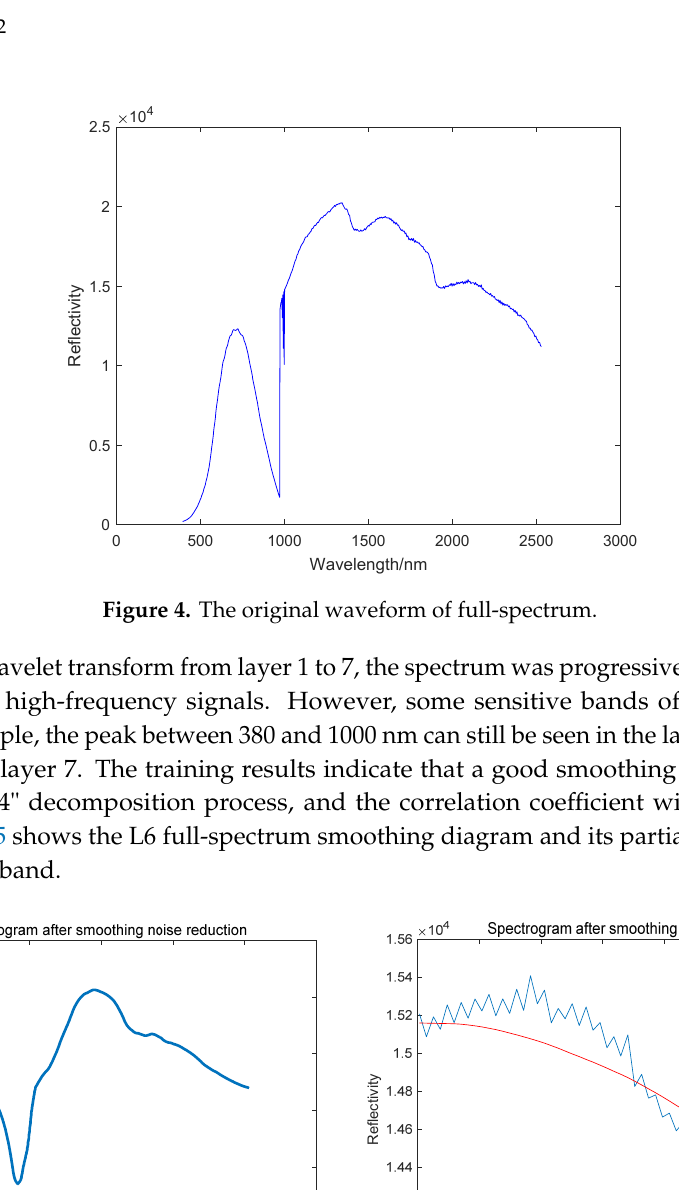
Table 2. Statistics of soil moisture content (SMC). Soil samples